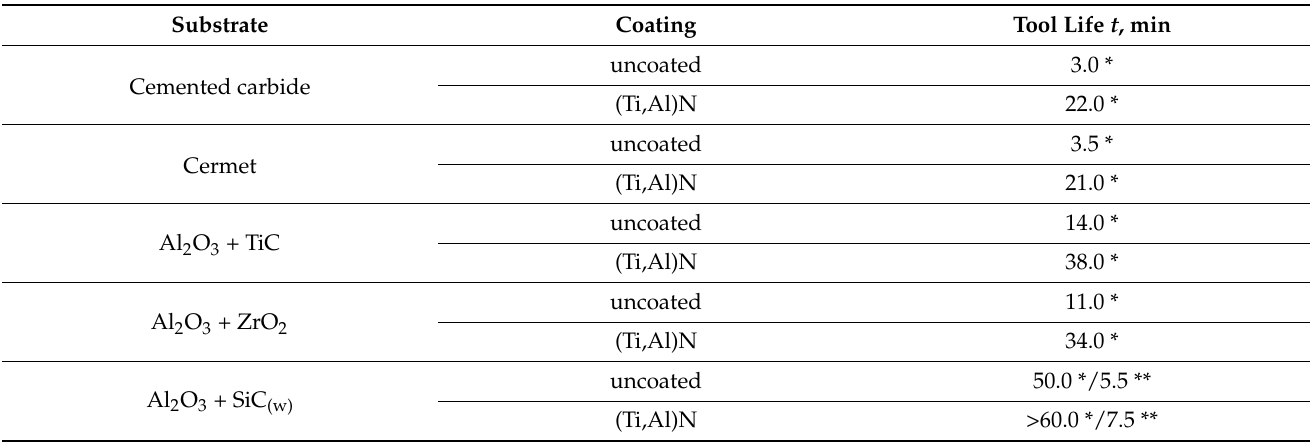
Table 2. Comparison of tool life for tools from cemented carbides, cermets, Al 2 O 3 + ZrO 2 , Al 2 O 3 + TiC and Al 2 O 3 + SiC (w) oxide ceramics with the (Ti,Al)N coatings.